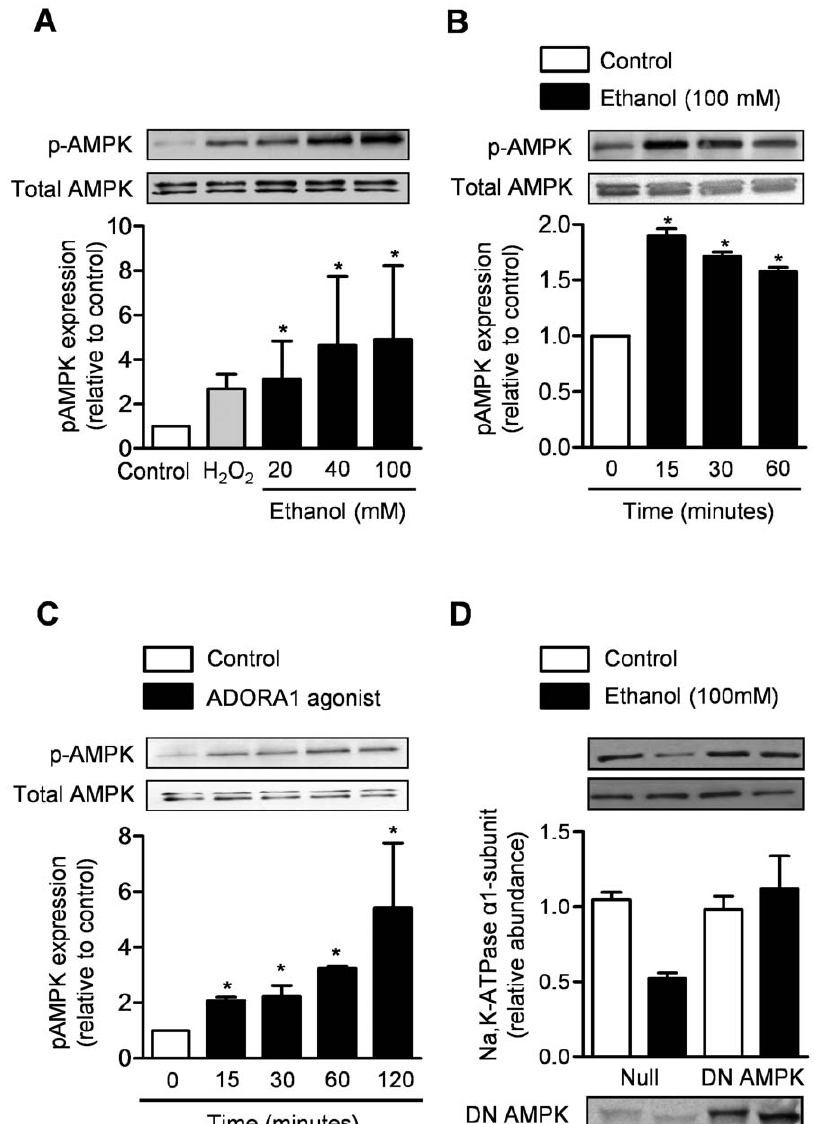
Figure 6. Alcohol-induced reduction in Na,K-ATPase is mediated via phosphorylation of AMP-activated protein kinase. Immunoblotting for phosphorylated AMPK (p-AMPK) and total AMPK was performed in cell lysates from ( A ) AEC 15 minutes after treatment with different concentrations of ethanol, H 2 O 2 (positive control) or media (negative control), ( B ) at different time points after the administration of ethanol (100 mM) or media or ( C ) after treatment with a ADORA1 agonist (CPA, 10 2 5 M) or control (DMSO). ( D ) Membrane abundance of the a 1 -subunit of Na,K-ATPase was evaluated via immunoblotting in rat AEC transfected with an adenovirus that expresses no transgene (Adnull) or that expresses a dominant-negative, kinase-dead variant of the AMPK a 1 subunit (AdDN AMPK) to generate a non-functional AMPK. N $ 3 for all measures, *p , 0.05 for comparison with untreated cells.